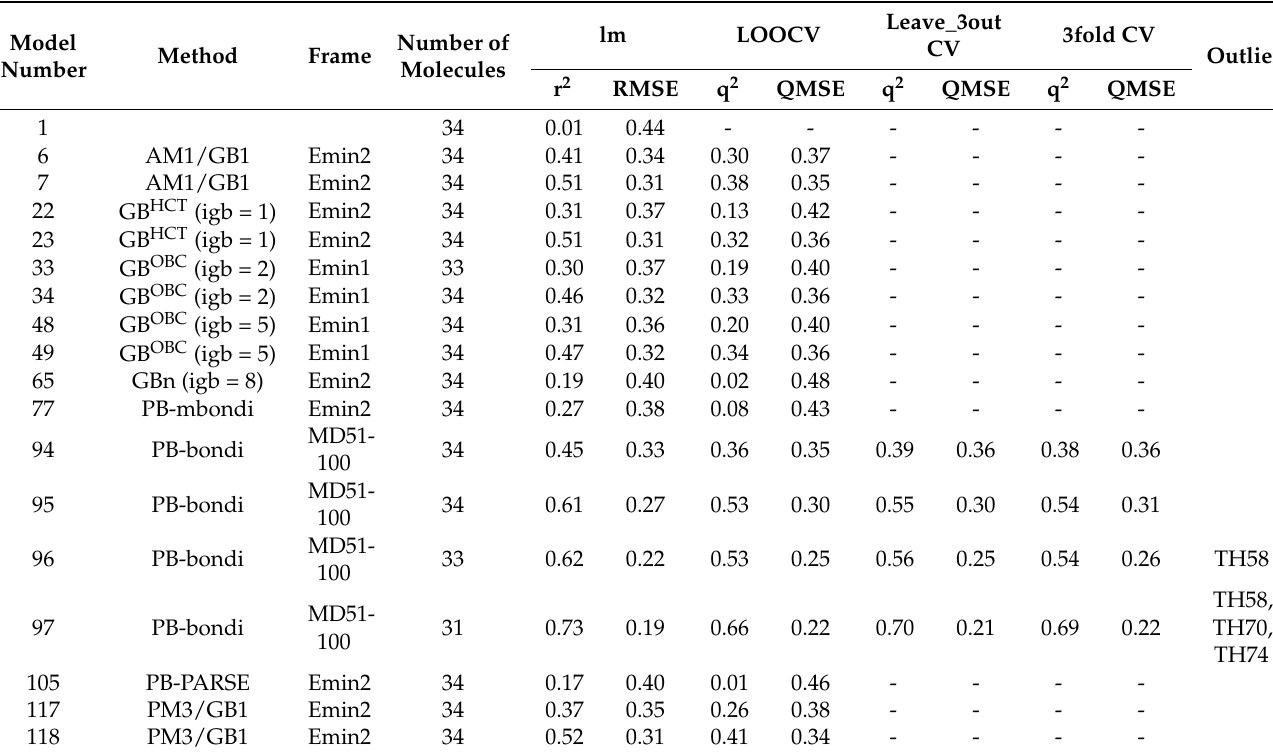
Table 2. Summary of statistical interpretation of the selected